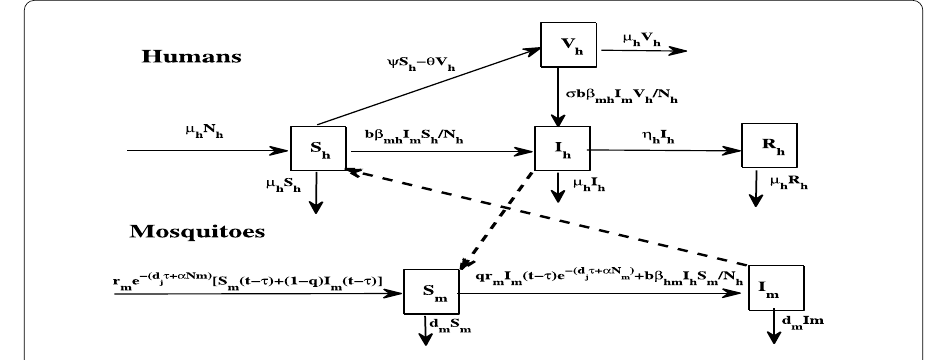
Figure 1 Flowchart of the transmission of Dengue virus transmission between mosquitoes and